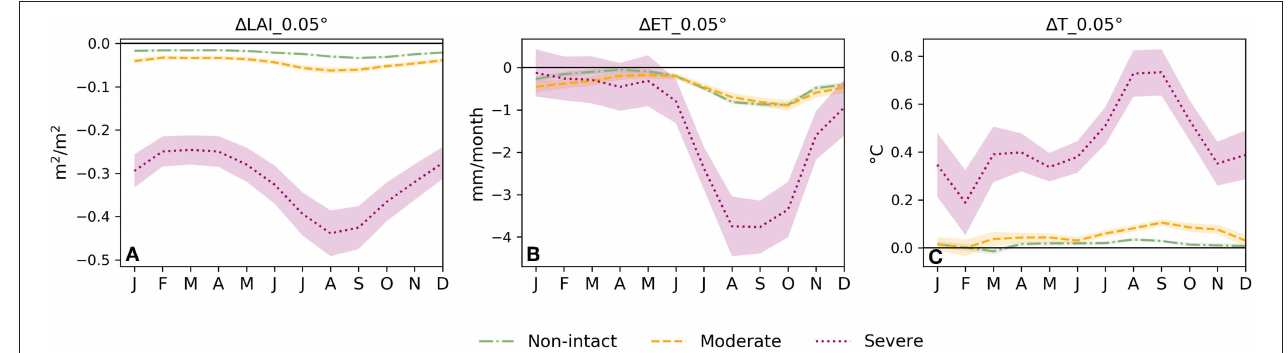
FIGURE 4 | Monthly changes in 0.05 ◦ remotely-sensed leaf area index (A) , evapotranspiration (B) , and daytime land surface temperature (C) , averaged over pixels in each disturbance category, and expressed relative to the changes observed over neighboring intact forest, for the period 2001–2013. Shading shows the 95% confidence intervals.